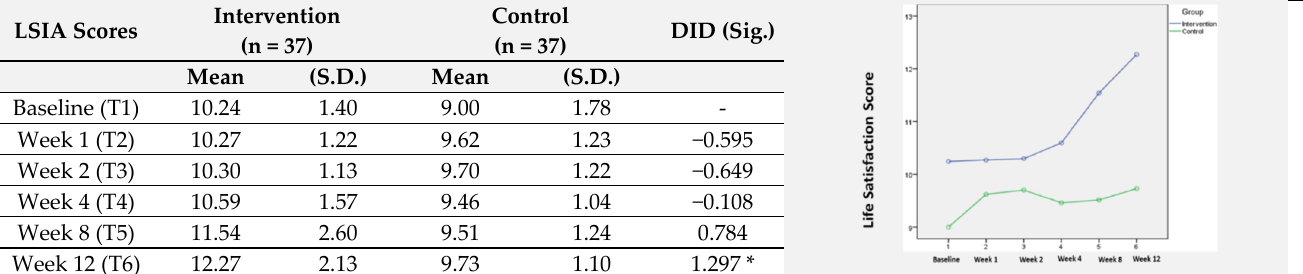
Table 3. Comparison of mean LSIA scores between groups over time.